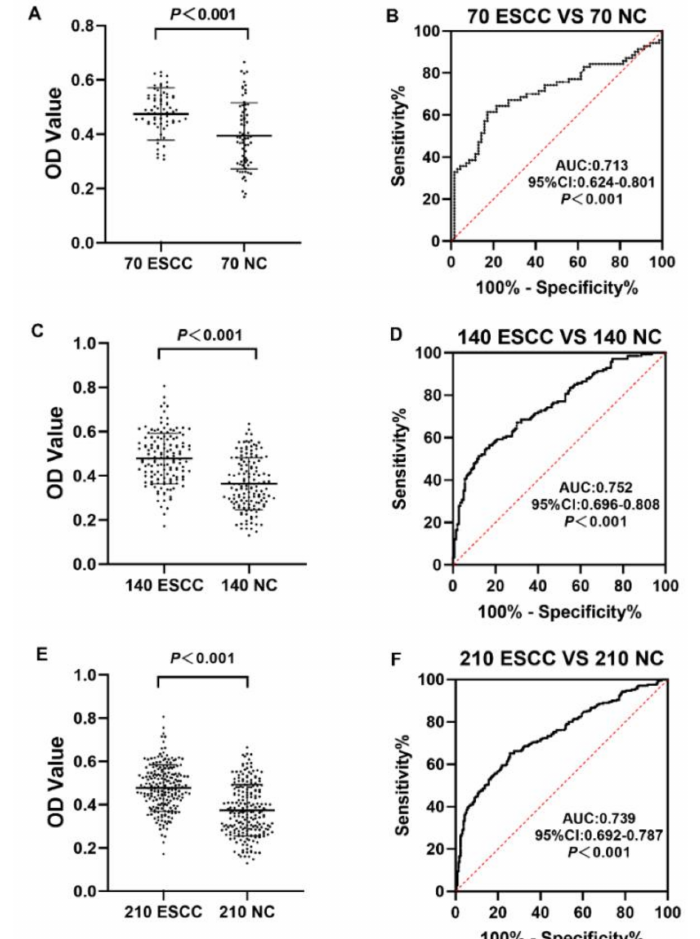
Figure 4. The expression level and diagnostic value of anti-CXCL8 autoantibody. The expression level of anti-CXCL8 autoantibody in the verification cohort ( A ), validation cohort ( C ) and all ESCC and all NC ( E ). The diagnostic performance of anti-CXCL8 autoantibody in the verification cohort ( B ), validation cohort ( D ) and all ESCC and all NC ( F